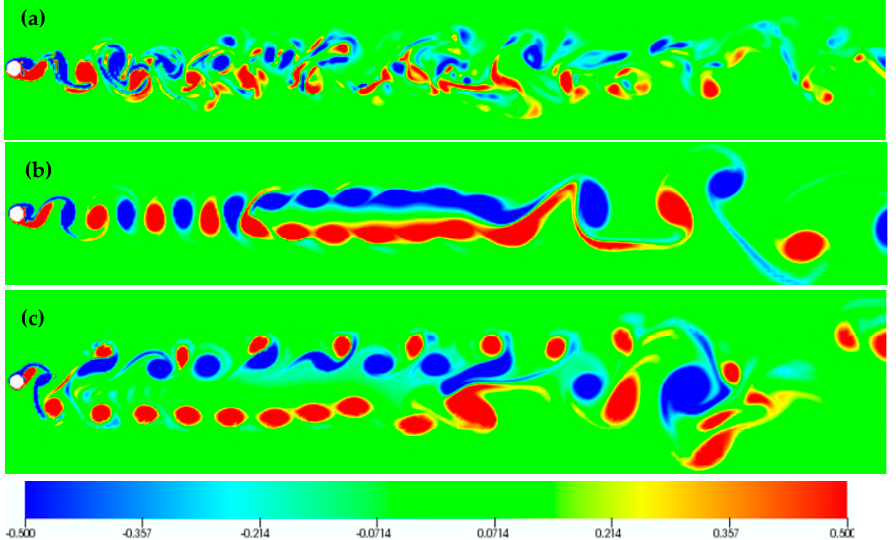
Figure 19. Clockwise cylinder oscillation: Instantaneous isocontours of spanwise vorticity for the plane z = 3 for F = 1.1 and ( a ) A y /D = 0.10, ( b ), A y /D = 0.30, ( c ) A y /D = 0.60.